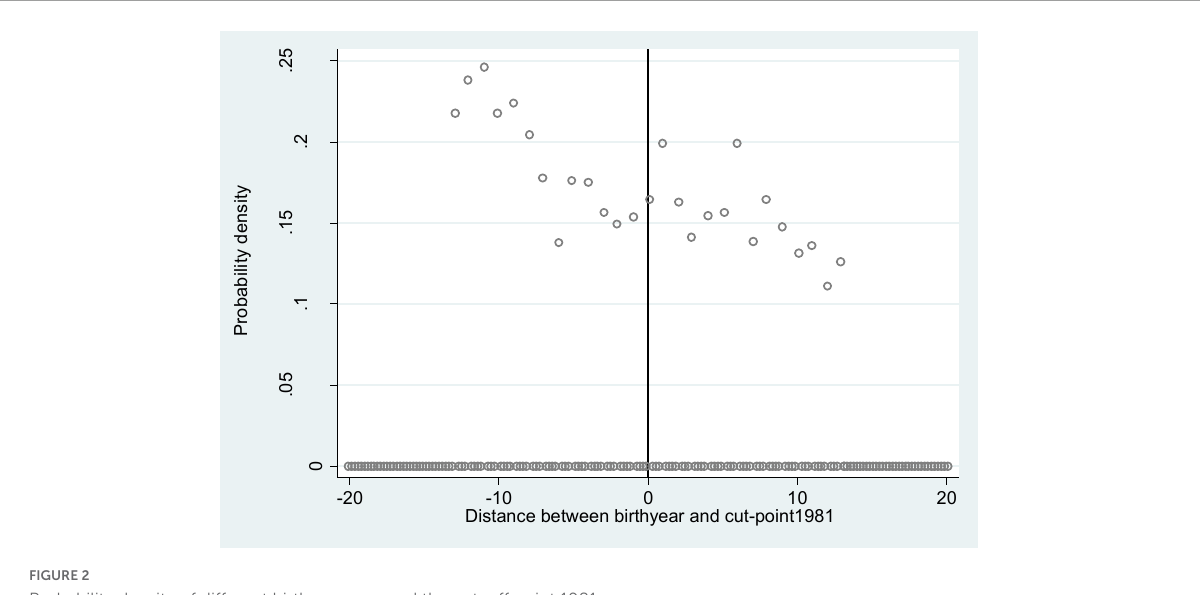
FIGURE2 Probability density of different birth years around the cut-off point 1981.